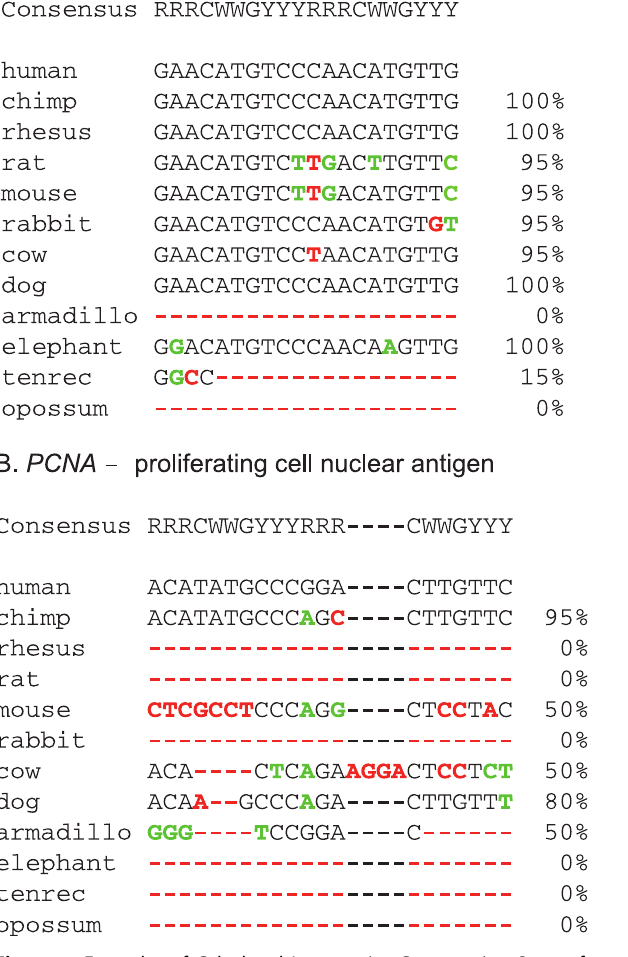
Figure 1. Examples of Calculated Interspecies Conservation Scores for TFBSs Multispecies alignments for p53 binding sites in the (A) CDKN1A and (B) PCNA genes are shown. Mismatches (green) from human that do not alter the p53 consensus motif, RRRCWWGYYY(N 0 (cid:2) 13 )RRRCWWGYYY, do not penalize the percent sequence identity, whereas consensus-altering mismatches and insertion/deletion events do (red). For the p53 binding sites, spacer elements are in gray and are not considered when calculating percent identity. R ¼ G or A; W ¼ A or T; Y ¼ C or T.